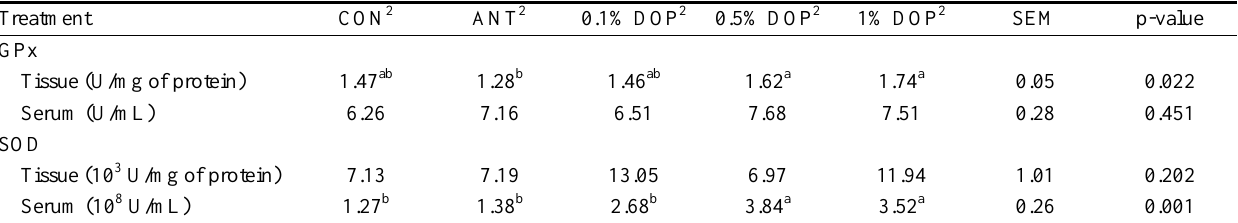
Table 6. Effect of dietary dried oregano powder (DOP) supplementation on superoxide dismutase (SOD) and glutathione peroxidase (GPx) in meat ducks 1